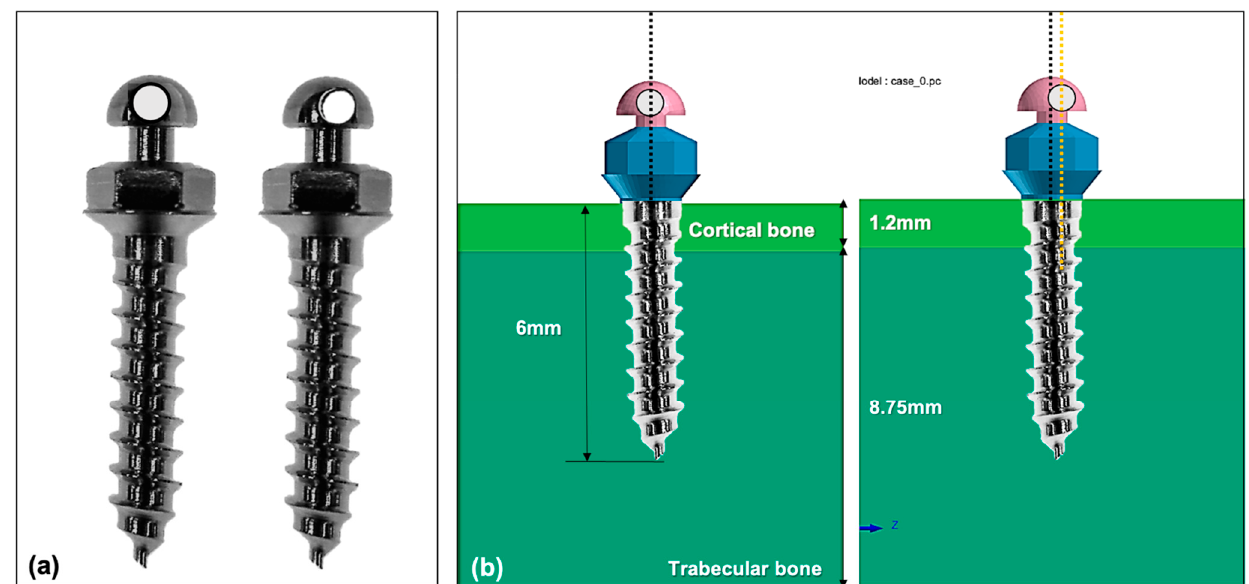
Figure 1. Two types of miniscrews based on the position of a hole in the head part: ( a ) the left one has a hole in the middle of the miniscrew’s head part (centric hole group), and the right one has a hole out of center of the miniscrew’s head part (eccentric hole group); ( b ) in the constructed model for this study, the two types of miniscrews were assumed to be placed totally into the alveolar bone. Thickness of the cortical bone was modeled at 1.2 mm, and the trabecular bone was thick enough to accept the whole length of the miniscrews. The left model is a miniscrew of the centric hole group and the right one is a miniscrew of the eccentric hole group. Table 1. The material properties used for the finite element analysis.